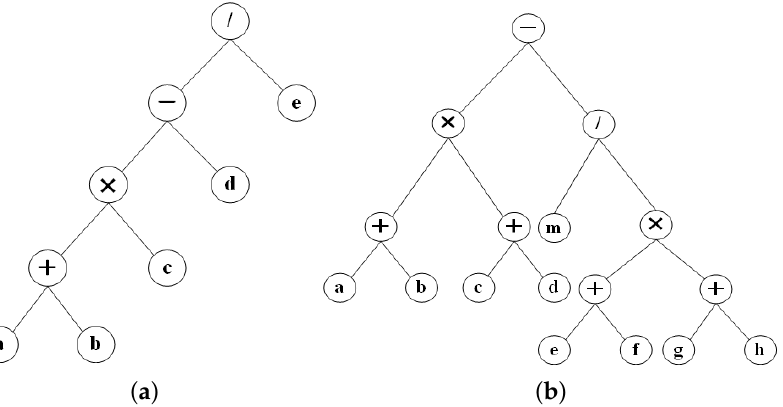
Figure 6. DFG of 2 example circuits. ( a ) ((a + b) × c − d)/e. ( b ) (a + b) × (c + d) − m/(e + f) × (g + h).